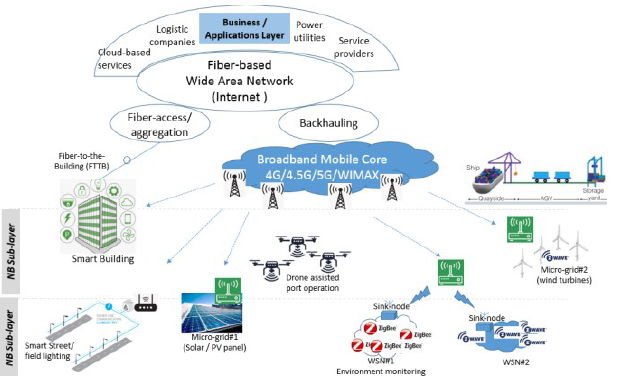
Figure 9 . Sub-layers of communications architecture in smart port.